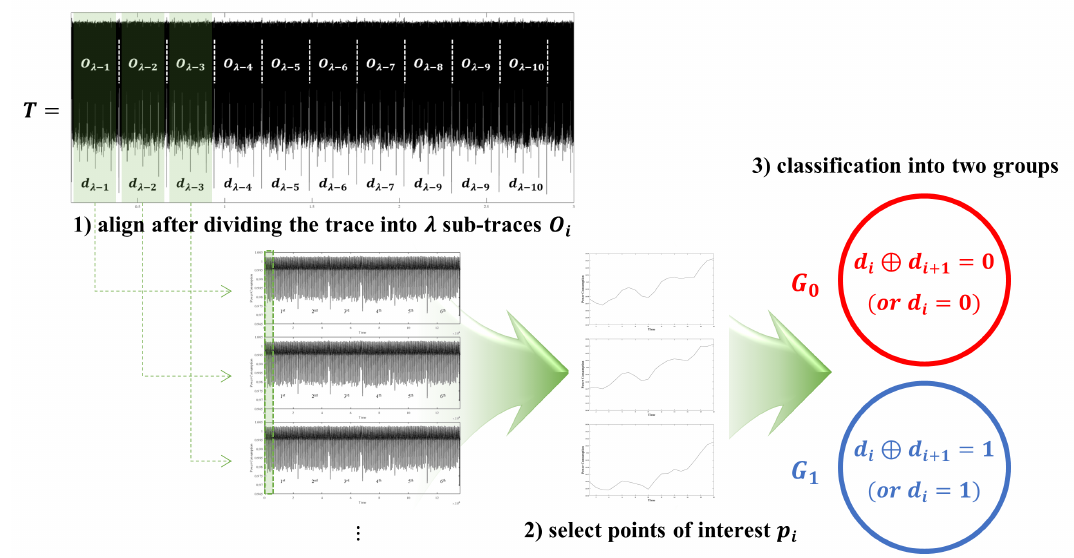
Figure 6. Key bit-dependent attack framework.